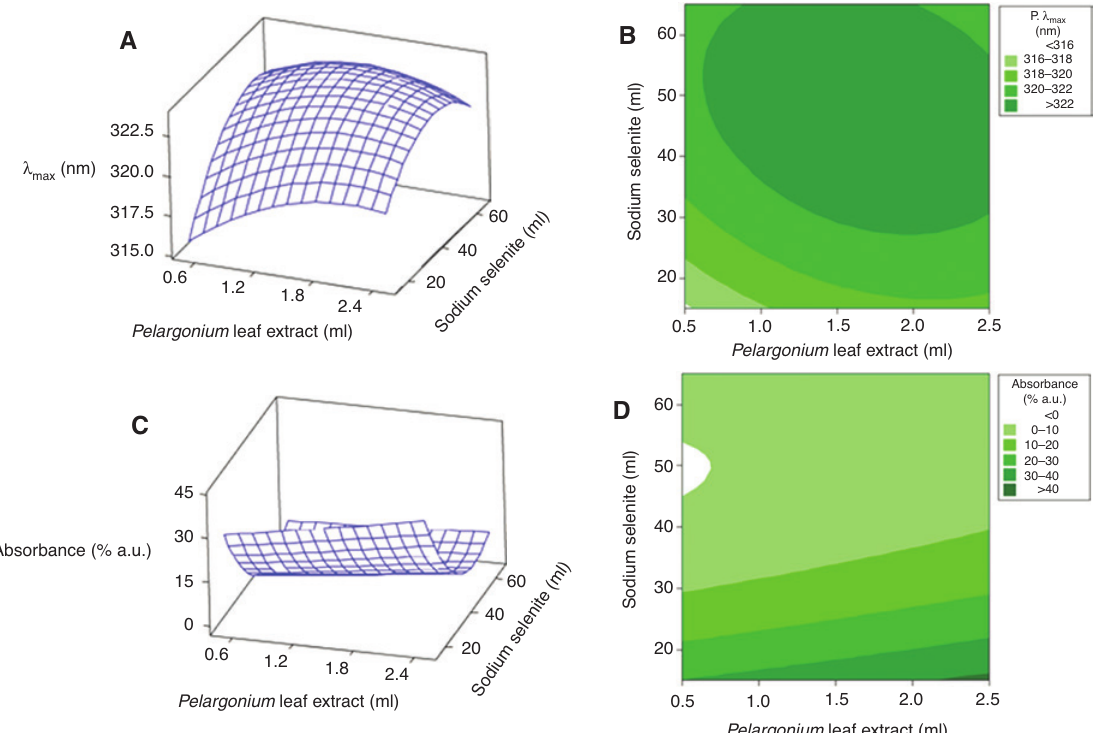
, and surface plot (C) and contour plot (D) for absorbance of the synthesized selenium max SeO solution (ml) and Pelargonium zonale leaves extract (PLE) 2 3